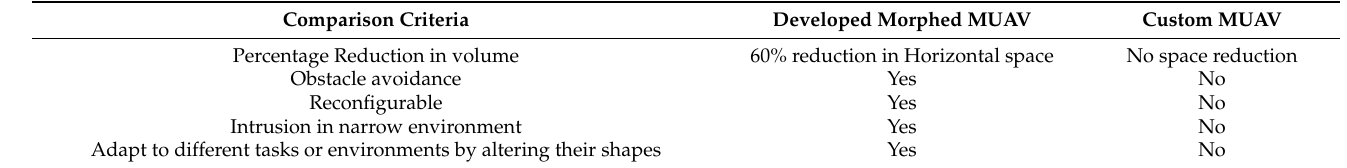
Table 1. Comparison of the developed morphed MUAV with conventional morphed MUAVs.